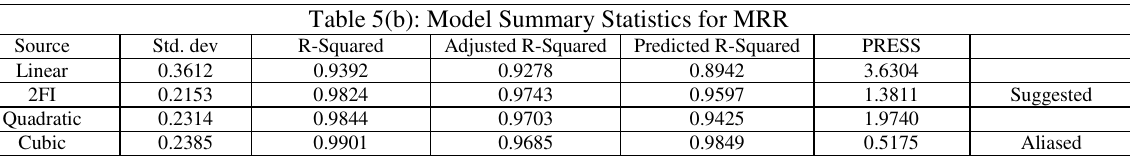
Table 5(b): Model Summary Statistics for MRR